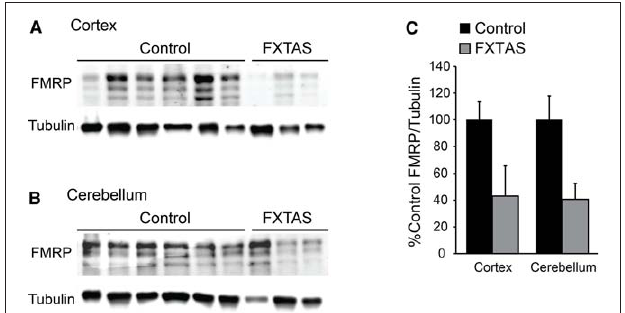
FIGURE 4 | Cortical and cerebellar FMRP expression in FXTAS patients. (A) Frontal cortex lysates from FXTAS patients ( n = 3) and the same control tissues ( n = 8) probed with α -FMRP 17722. (B) Cerebellar lysates from the same individuals as in (A) . (C) Normalized FMRP expression as a percent of controls, performed in technical